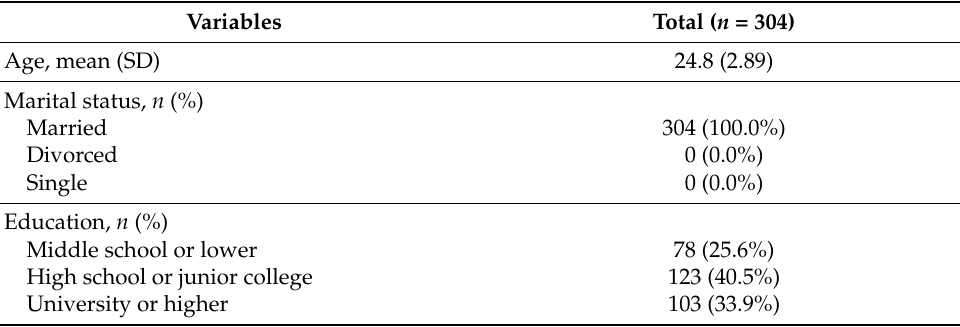
Table 1. Social-demographic and clinical characteristics of the participants.